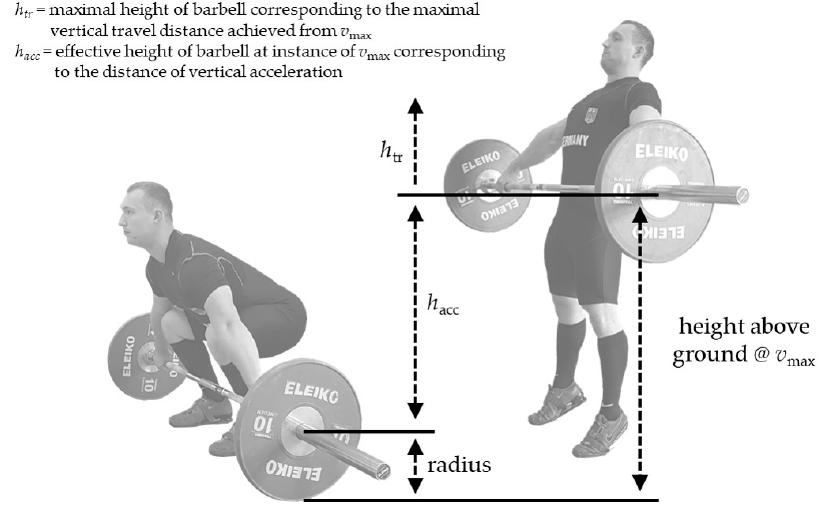
Figure 1. Schematic illustration of the snatch pull exercise from start position ( left ) to position of maximal vertical barbell velocity ( v max ) ( right ) with vertical barbell kinematic parameters. Averaged values from two consecutive snatch pull lifts for v max (80% and 110% con- dition) and h acc (110% condition) were used for further analyses. The snatch pull FvR 2 was modeled using linear regression with mean vertical barbell force ( F ) and velocity ( v ) from the 80% and 110% load conditions as input parameters. With reference to the approach presented by Samozino et al. [19], the mean vertical barbell force and velocity were computed from vertical barbell kinematics (i.e., v max , h acc